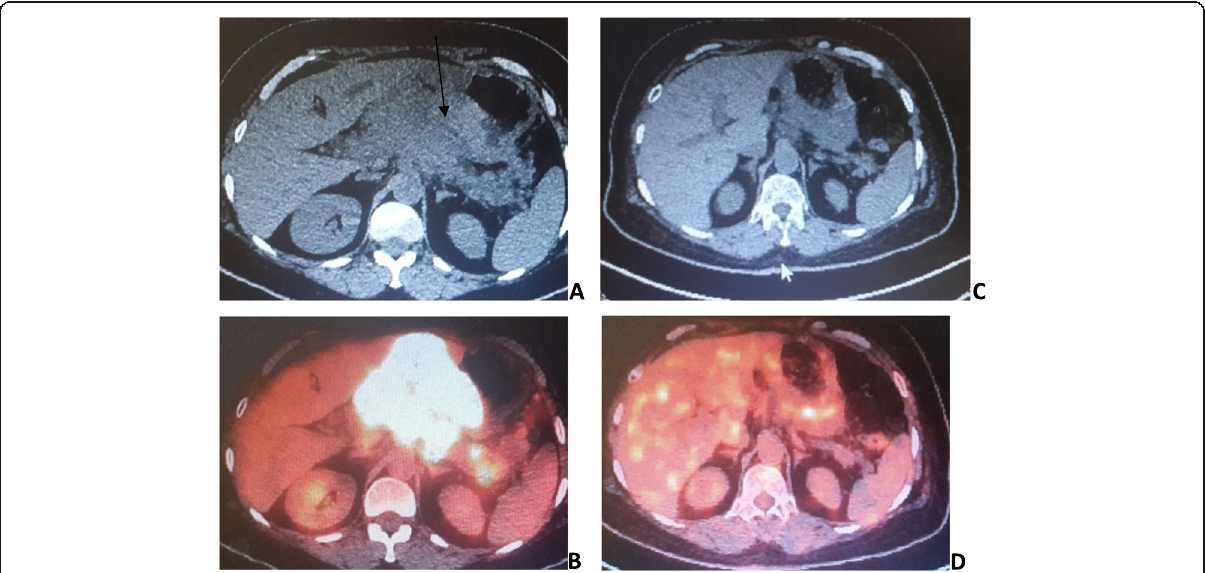
Fig. 1 A 49-year-old female patient with a history of enoscopically proven gastric MALT lymphoma ( a ) and axial CT abdomen ( b ) corresponding PET/CT-fused image showing gastric circumferential mural thickening forming a mass merging with gastrohepatic ligament-based soft tissue density (black arrow in a ) with avid uptake in the PET/CT fused image by the visual assessment method. c Axial CT abdomen ( d ) corresponding PET/CT-fused image 5 months later showing regressive course following treatment with residual gastric mural thickening.